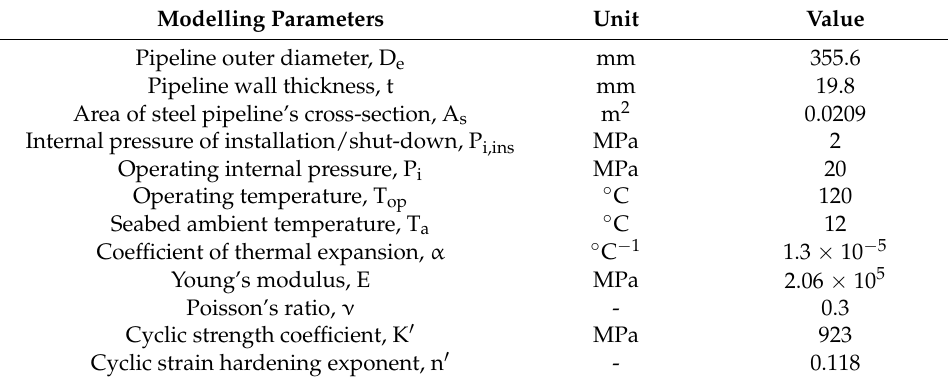
Table 2. Information for the example pipeline.